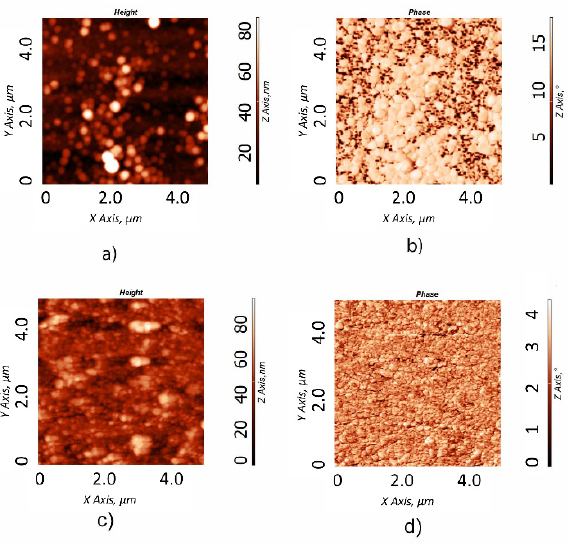
Figure 5. AFM images of the layer obtained with eight successive depositions of PC 71 BM:PTB7 ‐ b ‐ P4VP (1.1:1) blend WPNPs: ( a , b ) before annealing, and ( c , d ) after annealing. P4VP (1.1:1) blend WPNPs: ( a , b ) before annealing, and ( c , d ) after